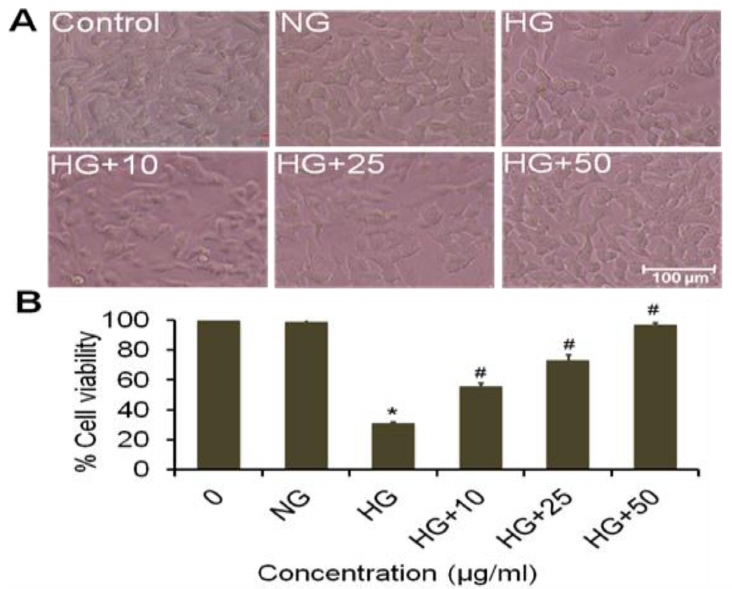
Figure 4. In vitro neuroprotective effects of GMT extract against mammalian neuroblastoma SHSY5Y cells ( A ) Photomicrograph of SHSY5Y cell line treated with NG, HG and 10 to 50 µg/mL concentration of GMT extract ( B ) Dose-response effects of NG, HG and GMT extract at different concentrations on SHSY5Y cell line for 24 h. All values were expressed as Mean ± SEM, * p < 0.05, HG vs NG; # p < 0.05, as compared to high glucose. Plants 2020 , 9 , x FOR PEER REVIEW